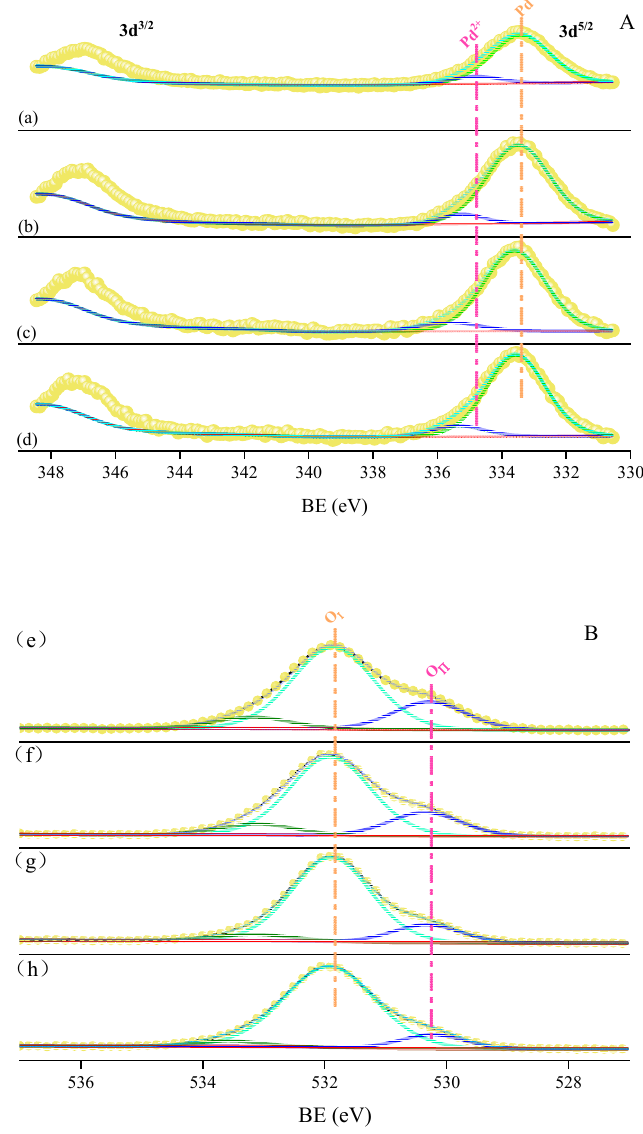
Figure 4. XPS spectra of ( A ) Pd3d ( a ) 0.1% Pd@U ( b ) 0.2% Pd@U ( c ) 1% Pd@U ( d ) 2% Pd@U.And (B)